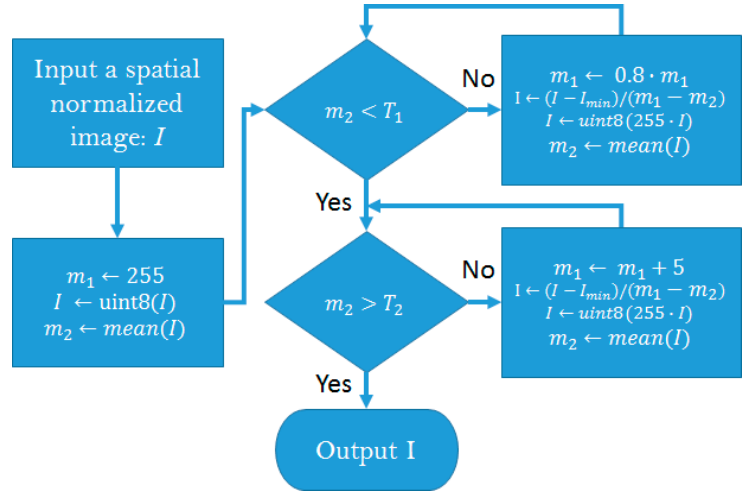
Figure 1. Flowchart of intensity normalization. During this process, intensities greater than 255 were pruned via the uint8 function. Notably, image I was converted to double precision before computation in every process block.